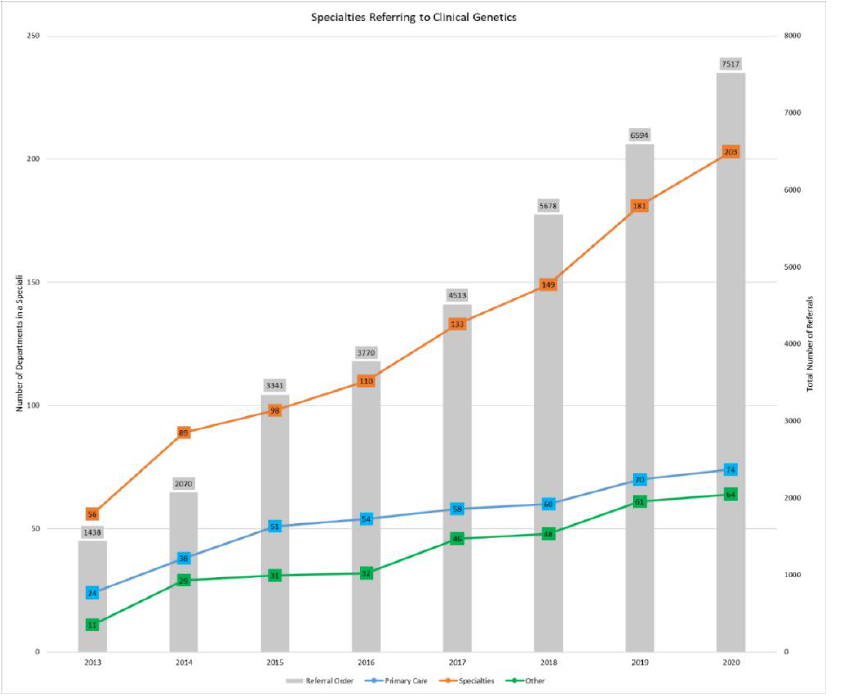
Figure 2. Growth over time in referring departments and clinical genetic referral orders. The line graph represents the growth in number of distinct departments referring to clinical genetics over time at Sanford Health. “Primary Care” includes family medicine and internal medicine